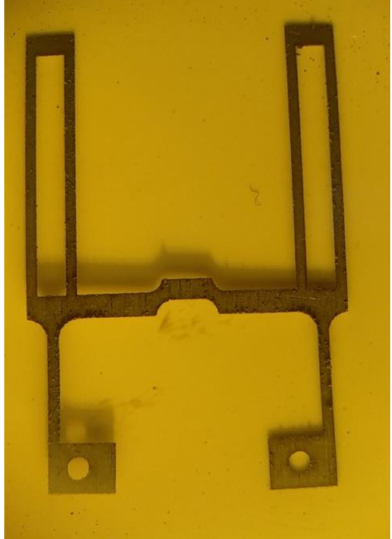
Figure 2. H-shaped elastic